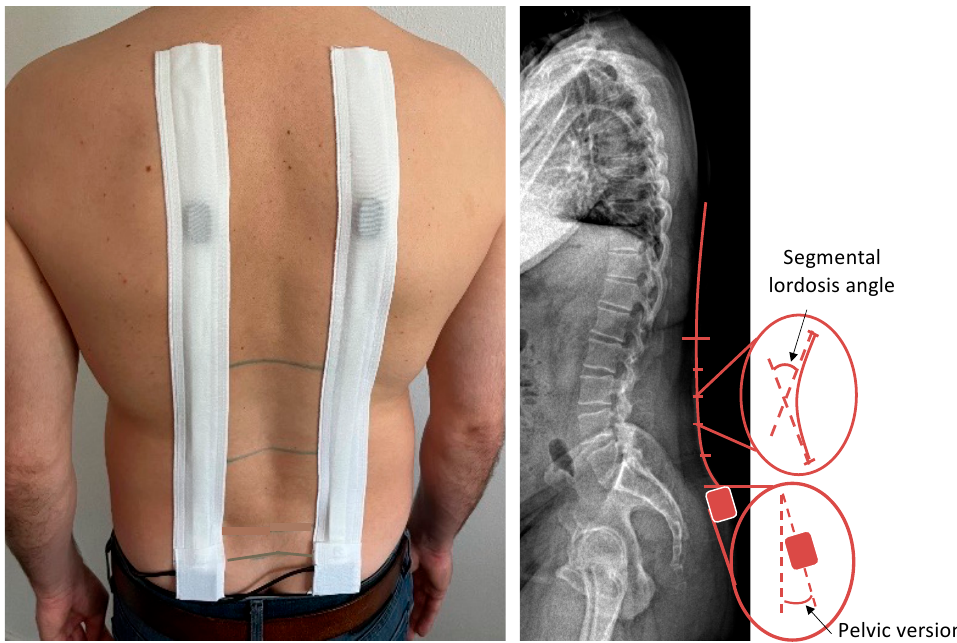
Figure 1. Epionics-SPINE measurement system.